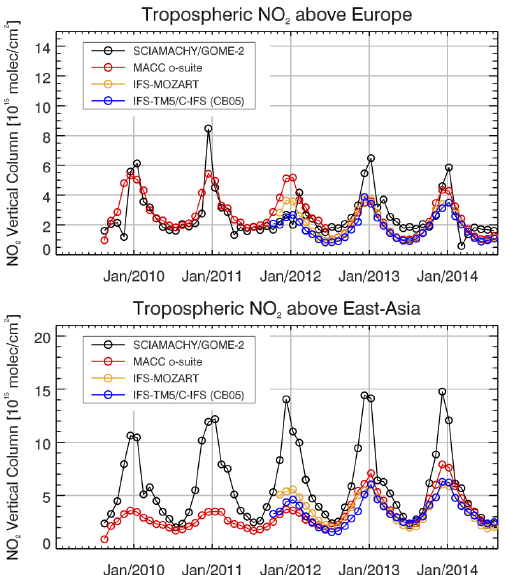
Figure 5. Time series of tropospheric NO 2 columns from SCIA- MACHY (up to March 2012), GOME-2 (from April 2012 onwards) compared to the o-suite (red) and the coupled IFS–MOZART model (orange) results for Europe and East Asia. The blue line shows C- IFS (CB05) results from December 2012